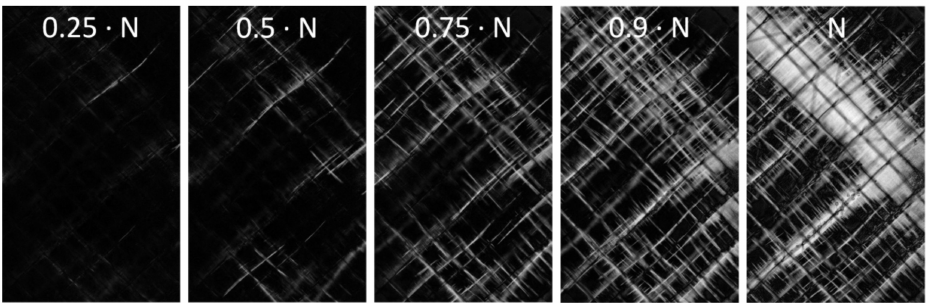
Figure 11. Exemplary transmitted light picture series (difference images) from 25% to 100% of cycles to failure N (0 wt.% (Ref), load level